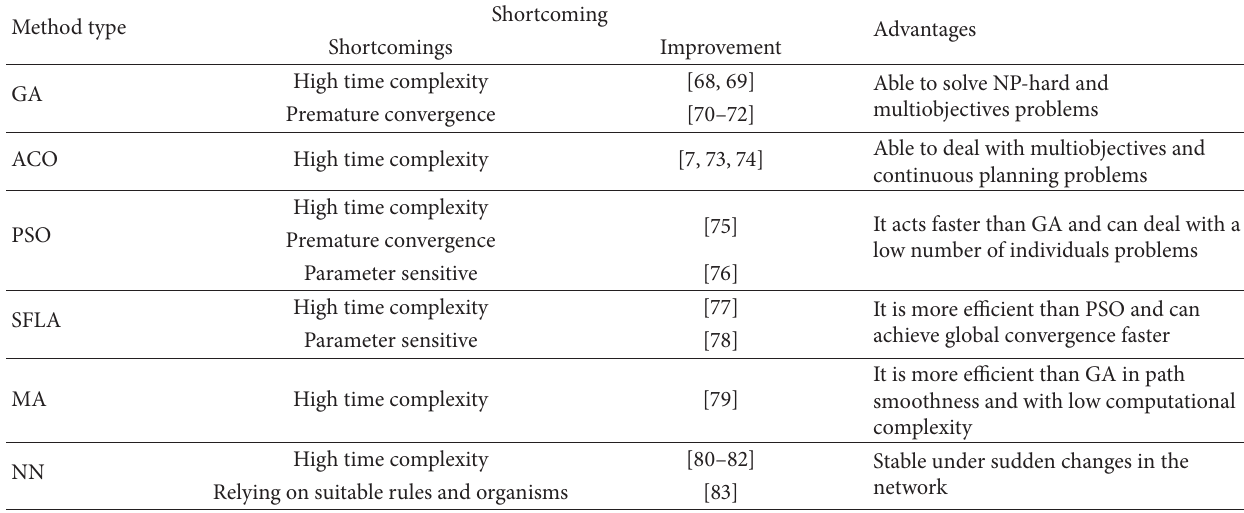
Table 5: Analysis of bioinspired